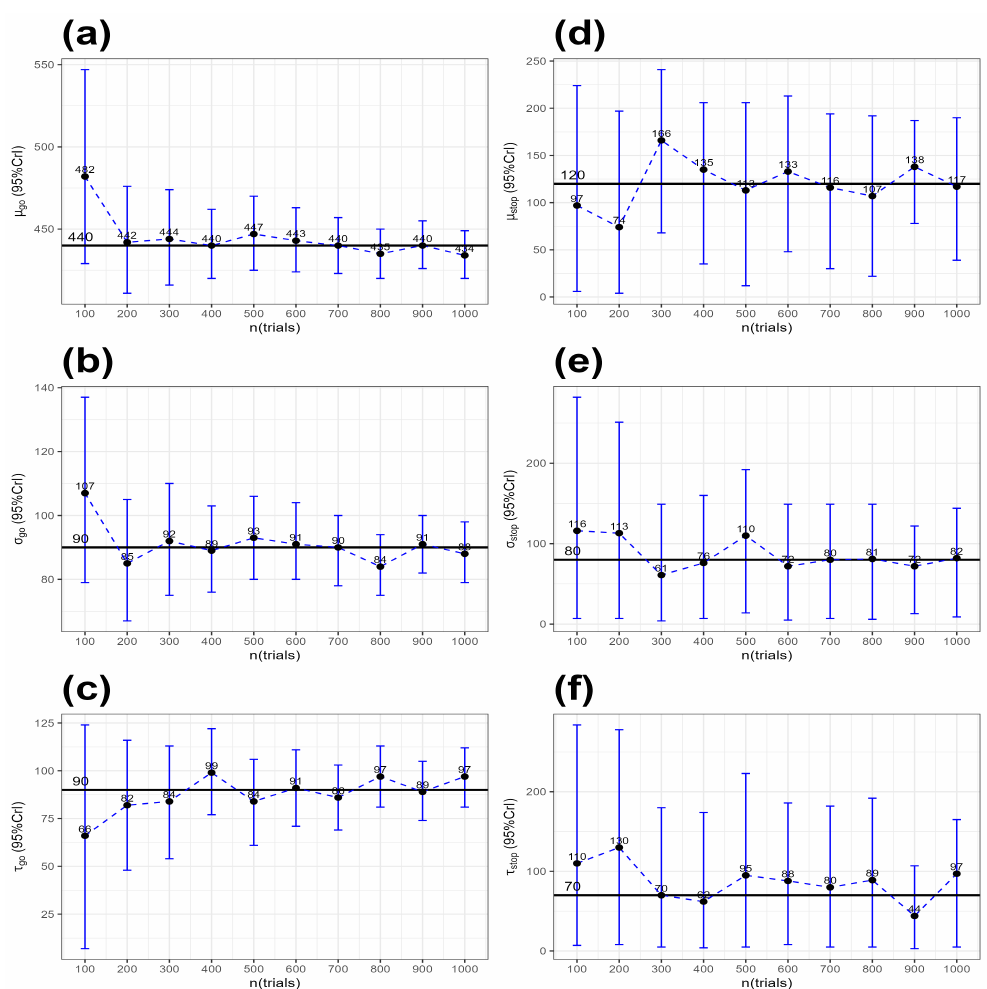
Figure 4. BEETS method parameters estimations for the SimSST-based simulated SST data with true parameter values on the black horizontal line: ( a – c ) GORT ExG parameters; ( d – f ) SSRT ExG